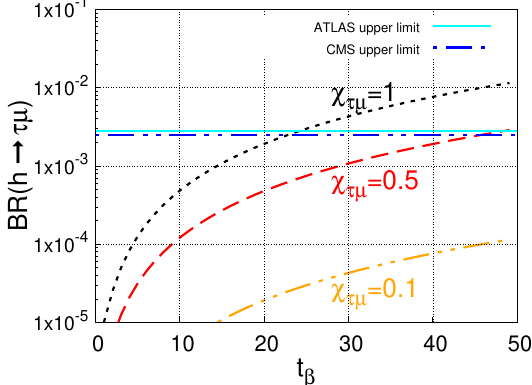
Figure 6 . Branching ratio of the h horizontal line represents the upper limit on